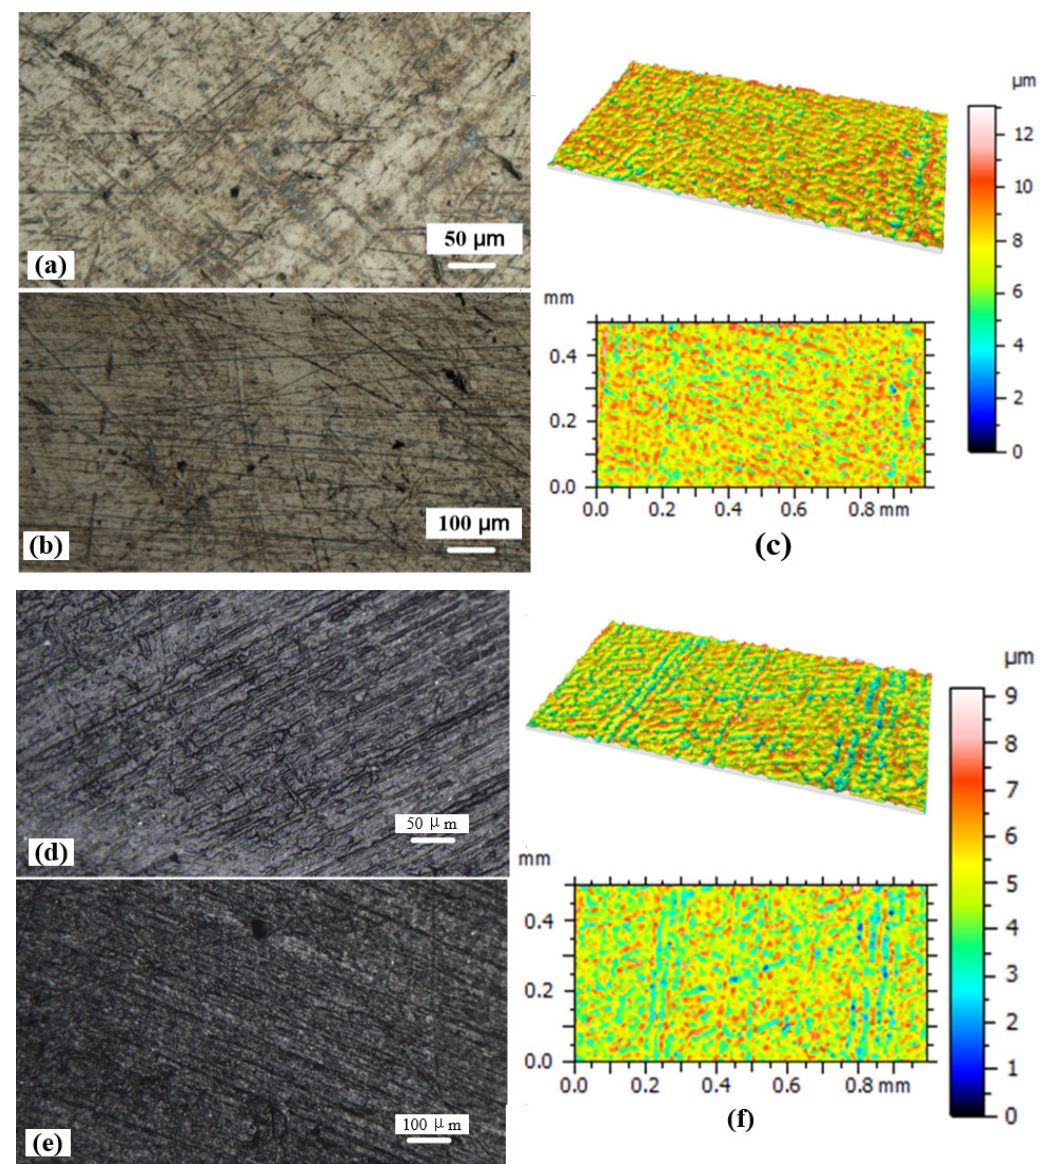
Figure 12. ( a – c ) The morphology of 316L sample (polished by 2000# abrasive paper) after friction experiment; ( d – f ) the OM images and 3D morphology of PTFE sample after friction experiment.